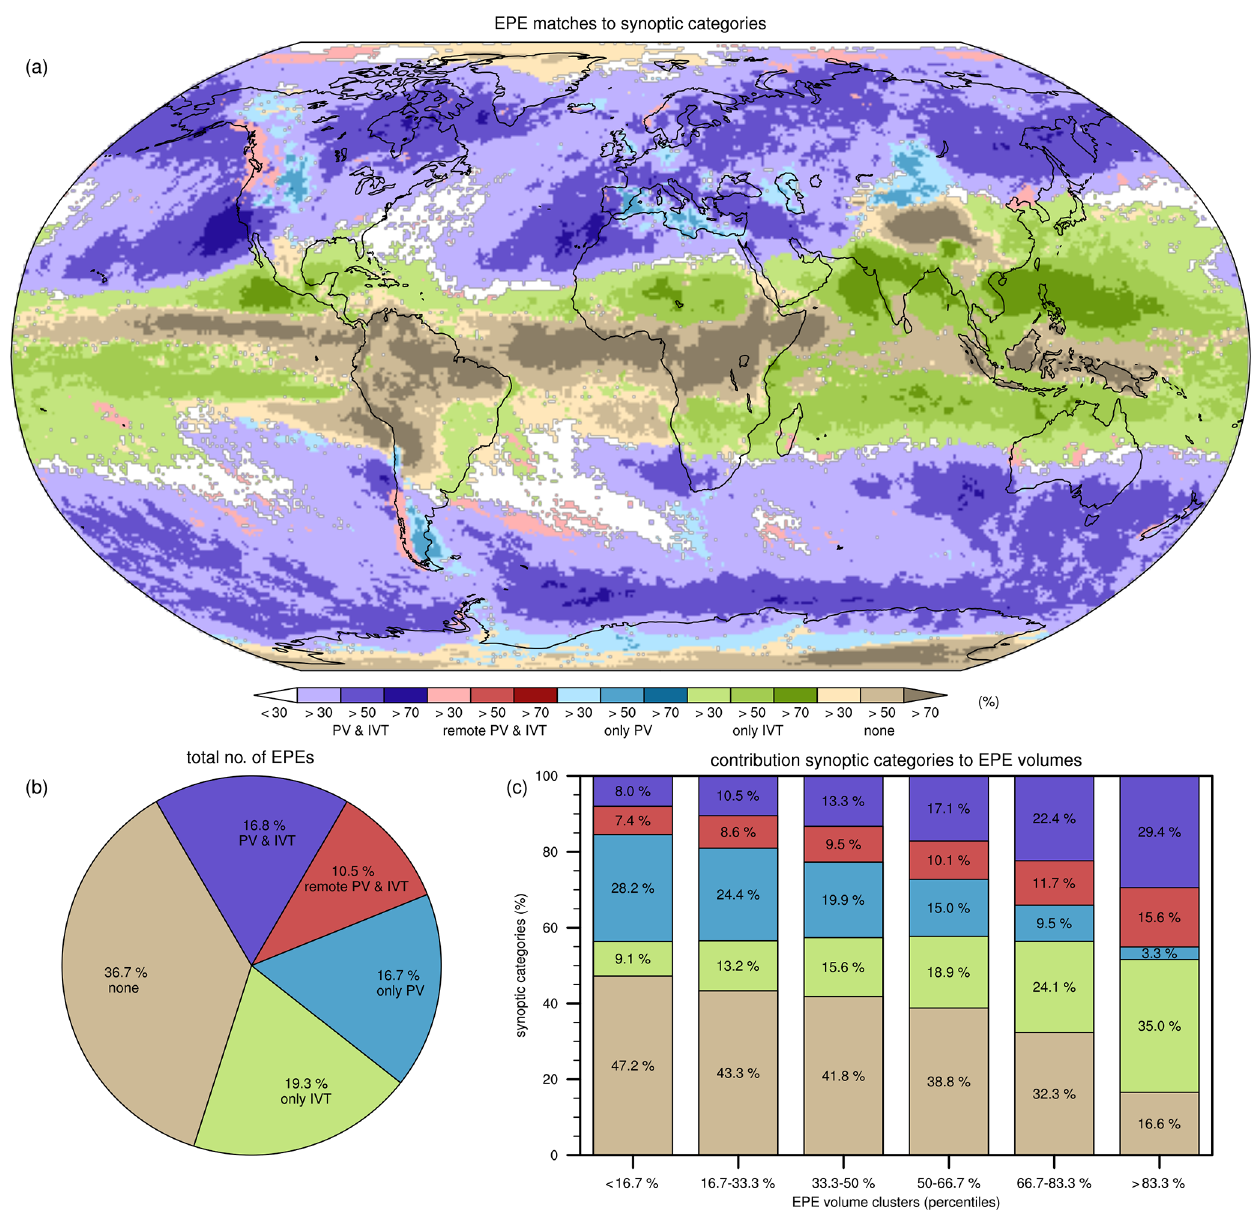
Figure 13. Climatology of EPEs linked to the five exclusive categories, as detailed in Sect. 6.2 and Table 1, as indicated by the legend from left to right: combined PV and IVT structures with a direct PV influence (PV and IVT, in purple), combined PV and IVT structures with only a remote PV influence (remote PV and IVT, in red), only PV structures (only PV, in blue), only IVT structures (only IVT, in green), and neither PV structures nor IVT structures (none, in brown-grey). In (a) their geographical distribution in fractions (%), (b) their share in the total number of EPEs, and (c) their share in six EPE clusters defined and ranked based on the precipitation volumes (%). Fractions in (a) are always shown for the category with the highest values, as shown in the legend, except for category 4 (remote PV and IVT), which is given advantage over category 3 (PV and IVT), provided the category 4 fractions exceed 30%, as indicated by the legend, with the aim to emphasize the regions where this category is relatively